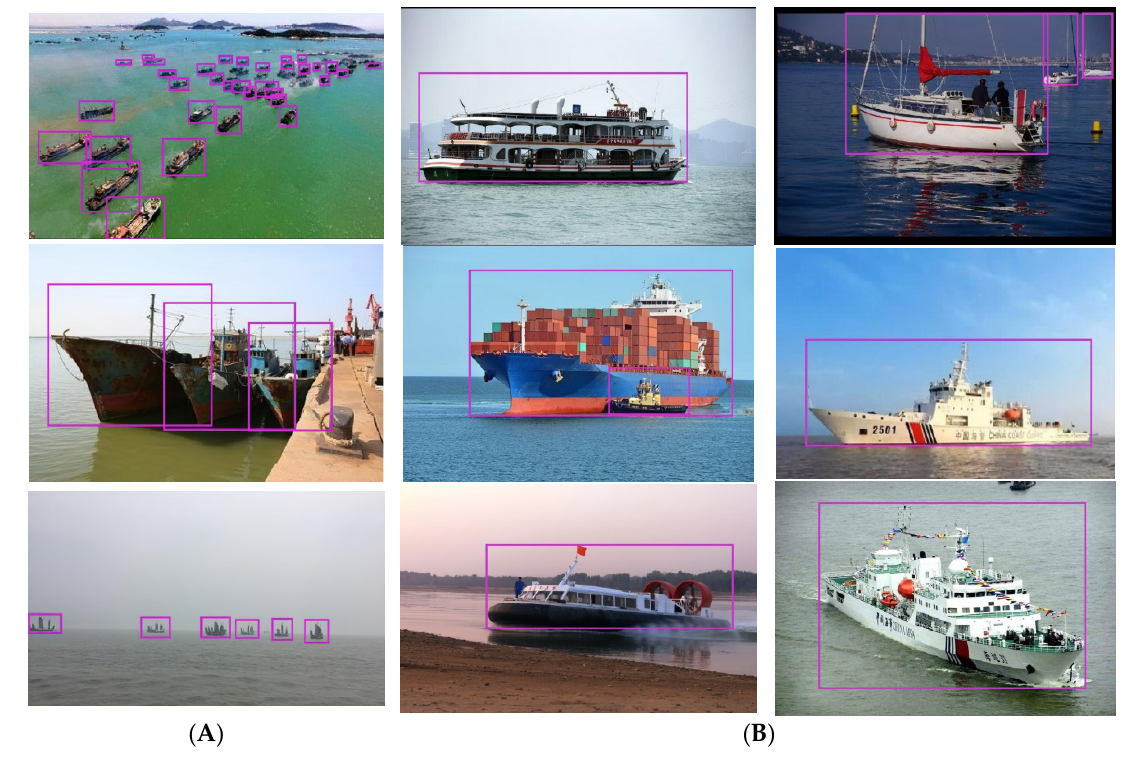
Figure 4. Recognition results of FMTI: ( A ) multi-objective, ( B ) simple or single objective.